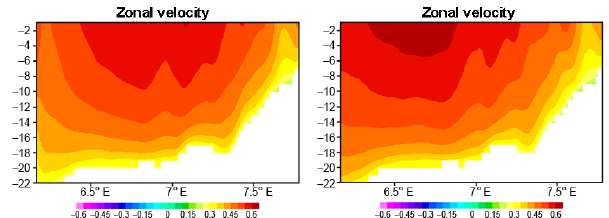
Figure 9. Zonal velocity vertical section (ms − 1 ) during storm Britta on 1 November 2006 at 03:00UTC (the location of the sec- tion is shown on Fig. 1) from the hydrodynamic-only model (left) and coupled model